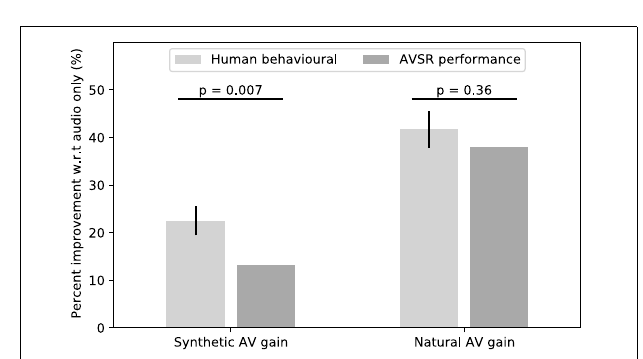
FIGURE 7 | The scores of an AVSR were improved by the synthetic videos, although the gain was less than that experienced by humans. The natural AV signals led to a higher gain, similar to that of our human